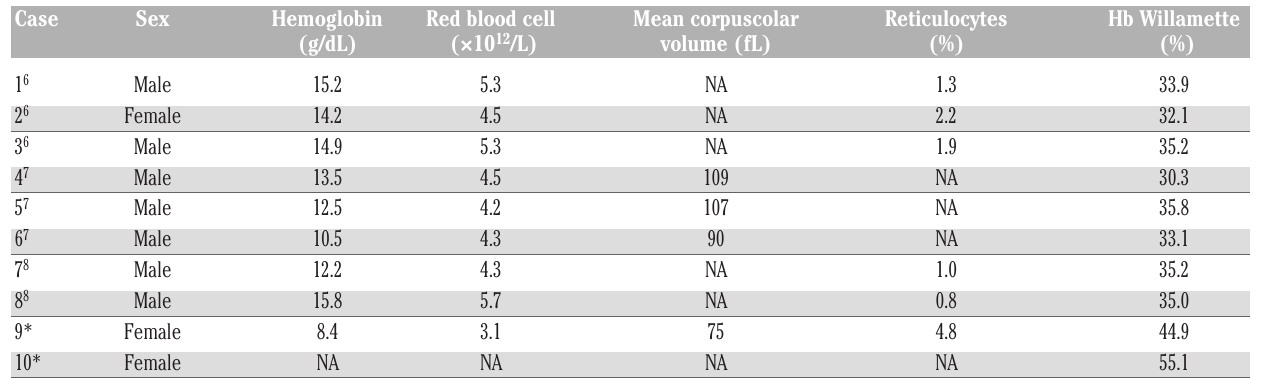
Table 1. Cases of hemoglobin Willamette described in literature. Case